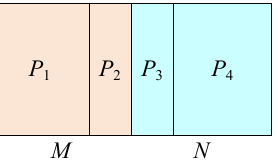
Figure 3. Schematic diagram of image region distribution.